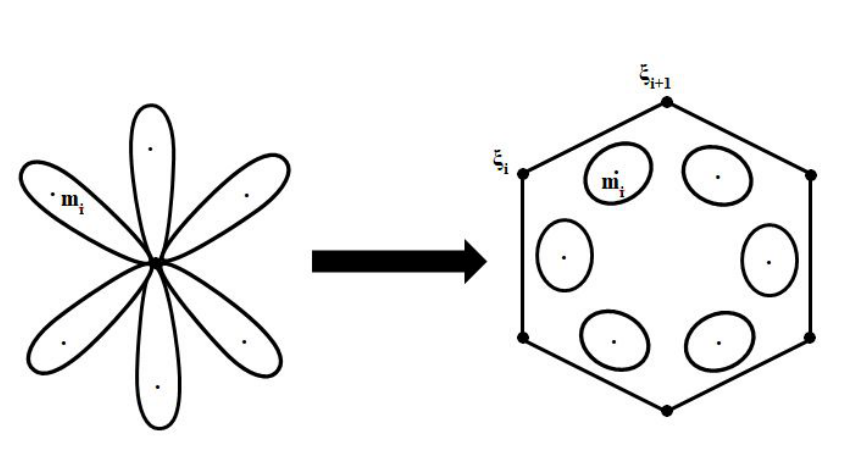
Figure 1. Formation of discs and a polygon due to splitting of